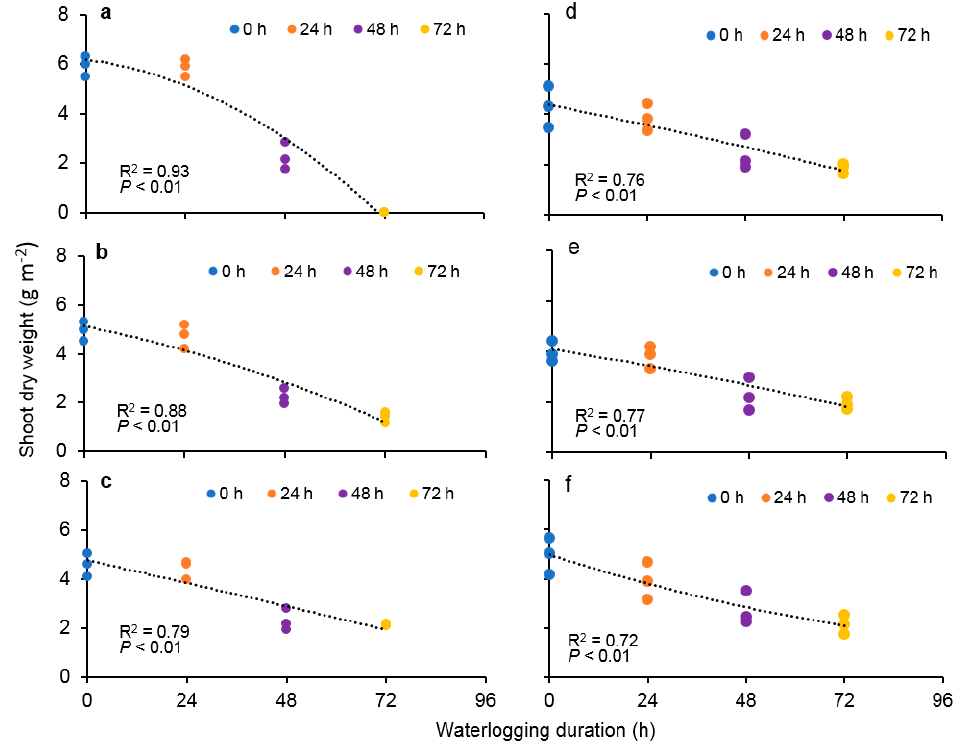
Figure 4. Effect of waterlogging duration on sunflower root dry weight for early sowing ( a ) emer- gence, ( b ) 2-leaf stage and ( c ) 4-leaf stage, and for late sowing ( d ) just after sowing, ( e ) 2-leaf stage and ( f ) 4-leaf stage. Each value was the mean of three replications.